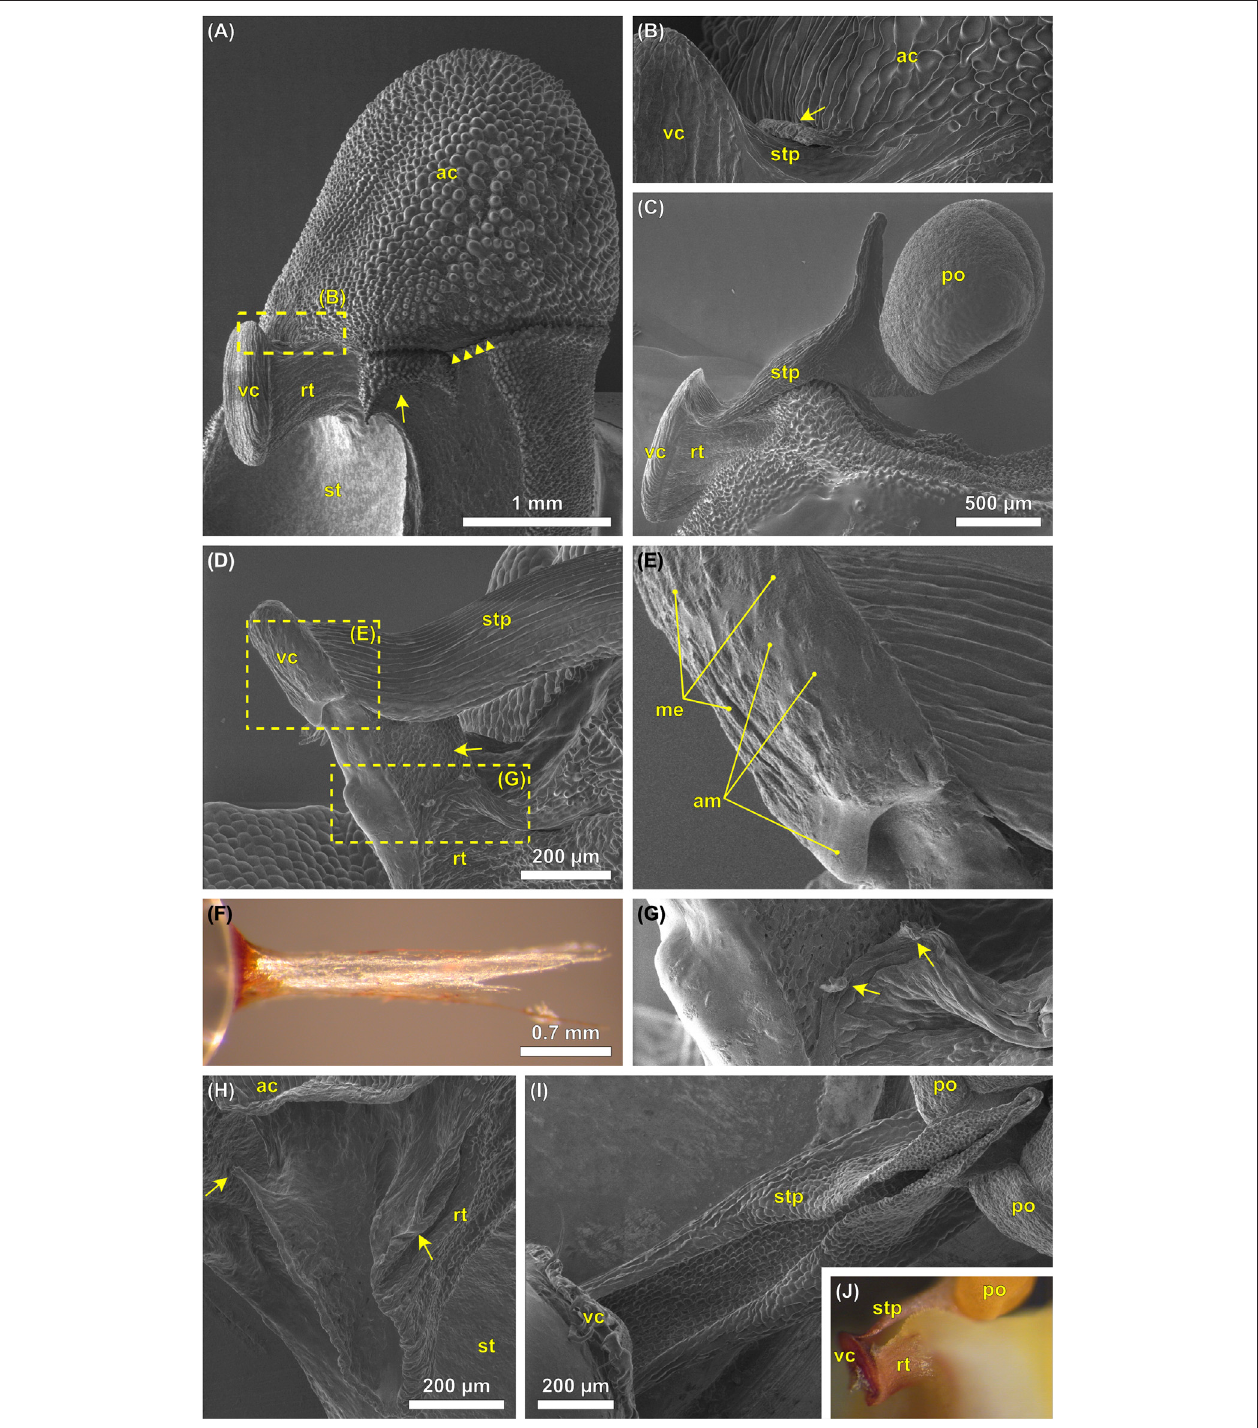
FIGURE 4 | (A – E,G – I) Cryo-SEM images and (F,J) digital photographs of the pollination apparatus of Oncidium wentworthianum . (A) A fl ower with unreleased pollinarium and stillattached anther cap. The column wings(staminodia)have been trimmed using a razorblade (arrow) toallow for alateral perspective. The connective tissuebetweenanther capand fl owerisruptured,probably duringsamplepreparation (arrowheads). (B) Detailofimage (A) showingthelip(arrow)oftheanthercapthat touchesthestipe. (C) Lateralviewofthepollinarium,whichstillsitsintherostellarpouch.Theanthercaphasbeenremoved.Thestipeisslightlybentupwardswhat might have been caused by removal of the anther cap and/or by the freezing process during cryo-SEM. (D) A pollinarium that was manipulated with a pinhead. The viscidiumispartlyreleasedfromitsoriginalpositionrevealingthescutellumatitsbackside(arrow).Therostellarpouchtherebywasdeformed.Theadhesivesubstanceof